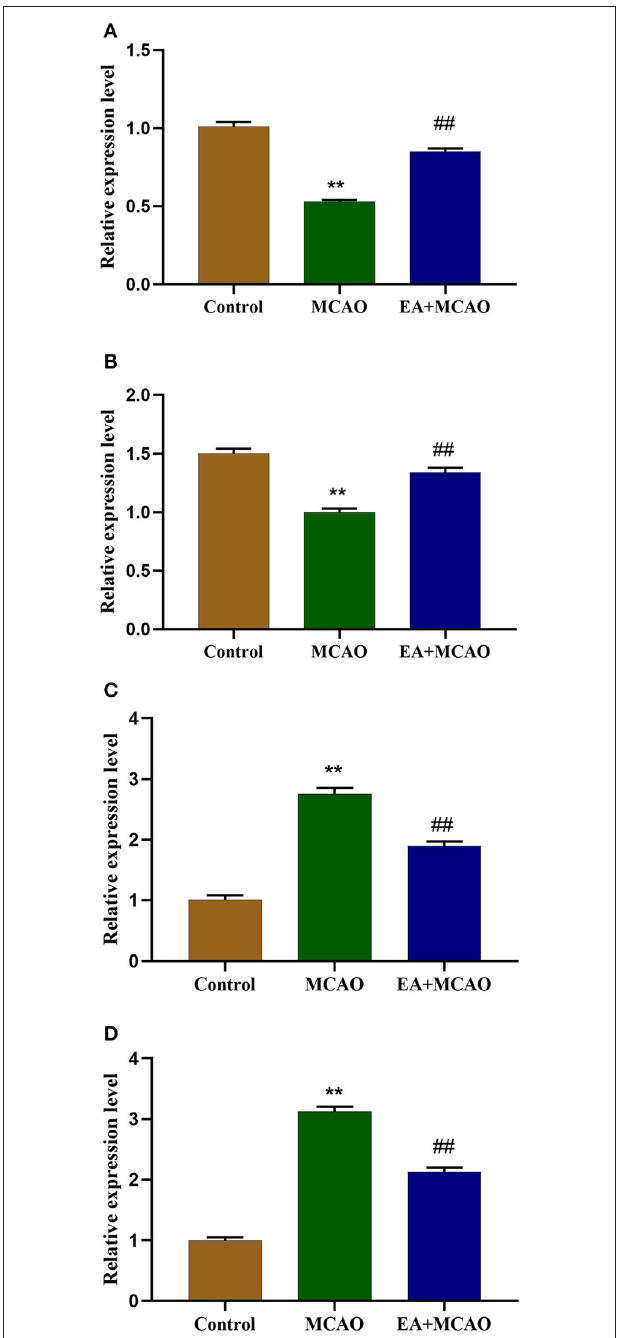
FIGURE 4 | Levels of GPX4 mRNA (A) , FTH1 mRNA (B) , Tf mRNA (C) , and TfR1 mRNA (D) in each group. Results are expressed as means ± SEM ( n